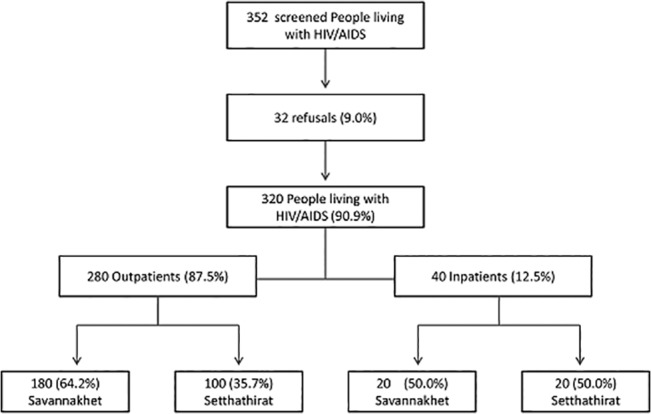
Flow chart of the study population.